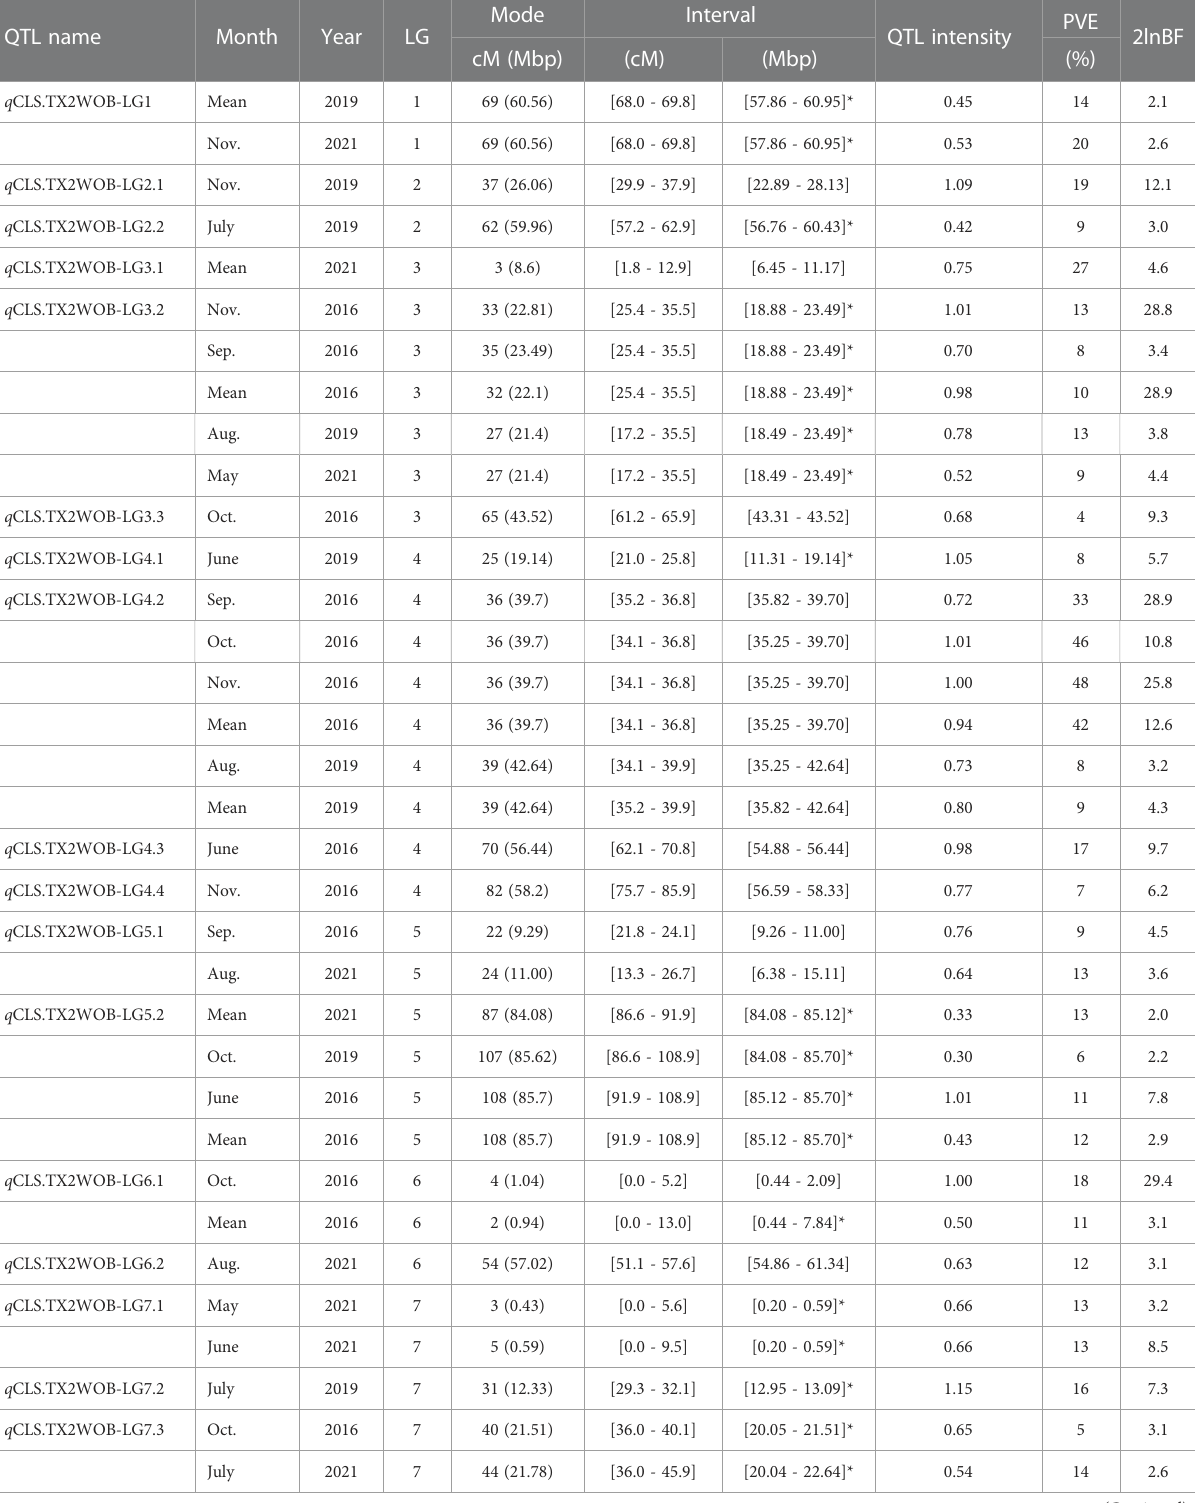
TABLE 1 QTL name, linkage group (LG), interval, QTL peak mode (Mode), posterior intensity (QTL intensity), phenotypic variance explained (PVE), and Bayes factor (2lnBF) for the cercospora leaf spot (CLS) evaluated in Texas on 11 rose diploid populations (TX2WOB) across multiple months and overall mean in 2016 in College Station (CS) and on a ten-population subset in 2019 and 2021 in Somerville